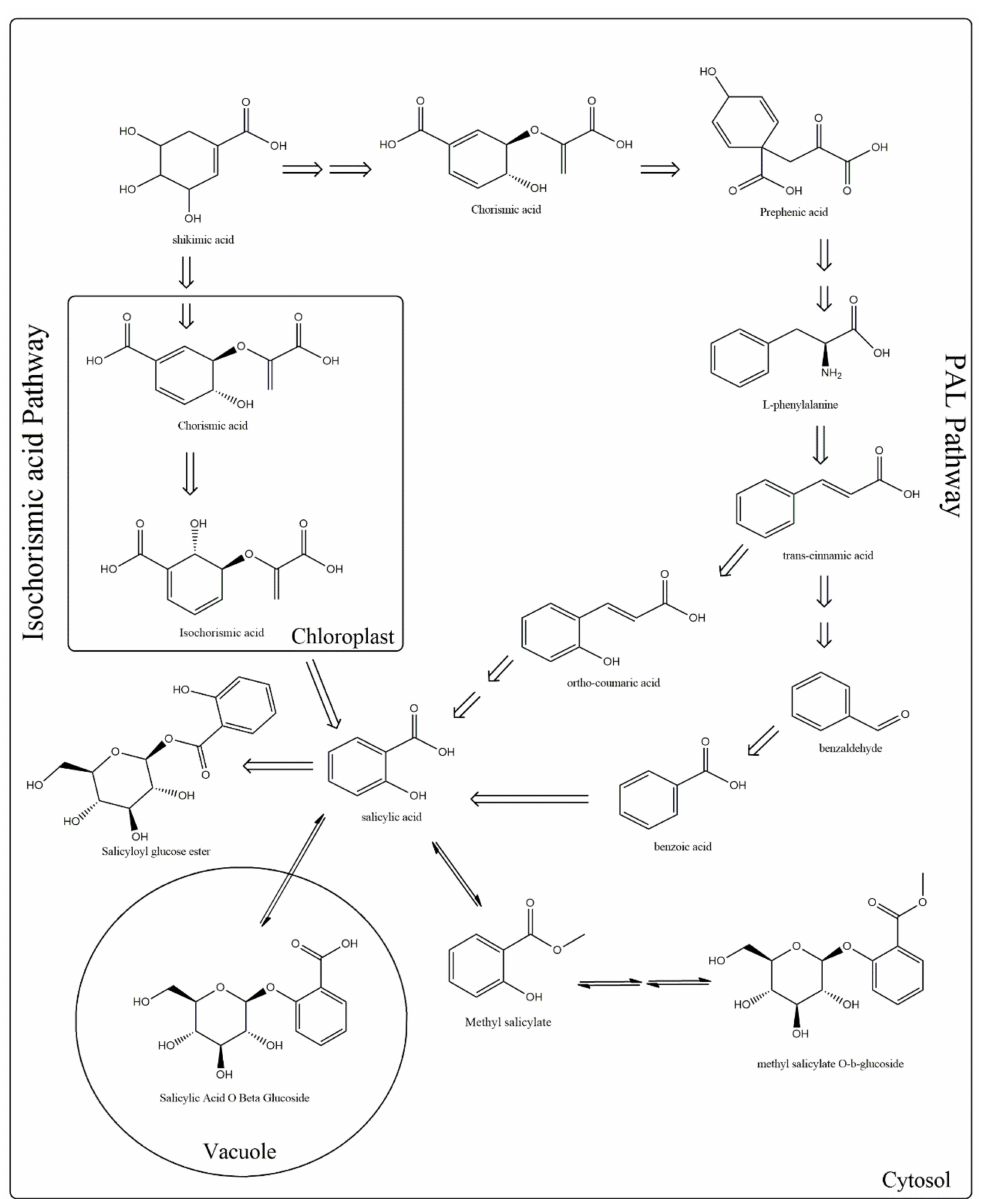
Figure 1. Metabolic pathways involved in the biosynthesis of salicylic acid (SA). Plants use two pathways for SA production, the phenylalanine ammonia-lyase (PAL) (which is divided into two sub-pathways, benzoic acid, and o-coumaric acid) and the isochorismate. In both routes, shikimate serves as a